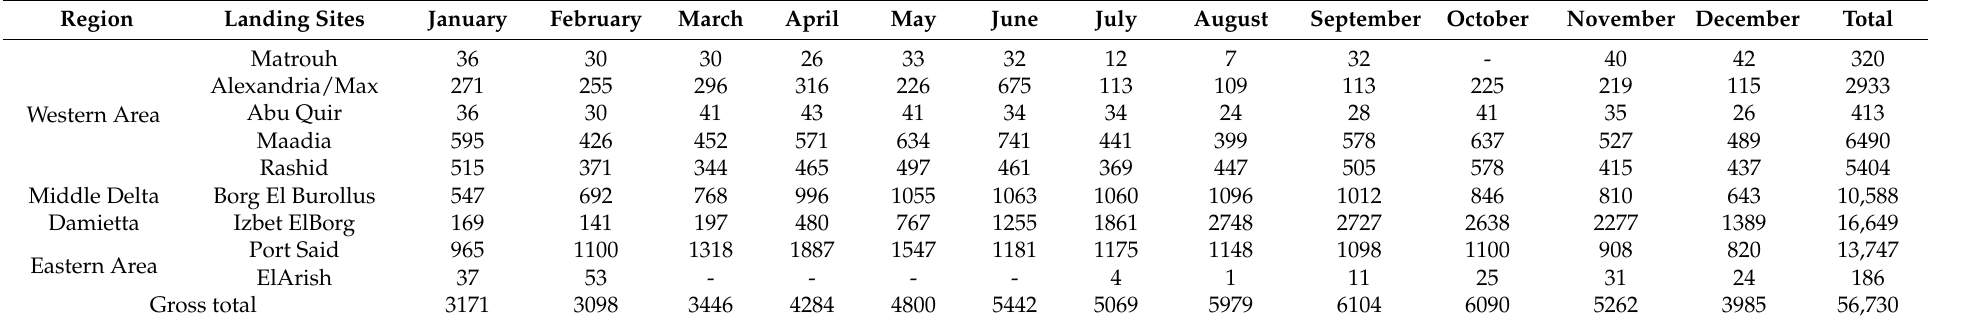
Table 1. Examples of monthly catch results of Sardinella during 2018 and the quantity per landing site (Ton), (-) no data available. Region Landing Sites